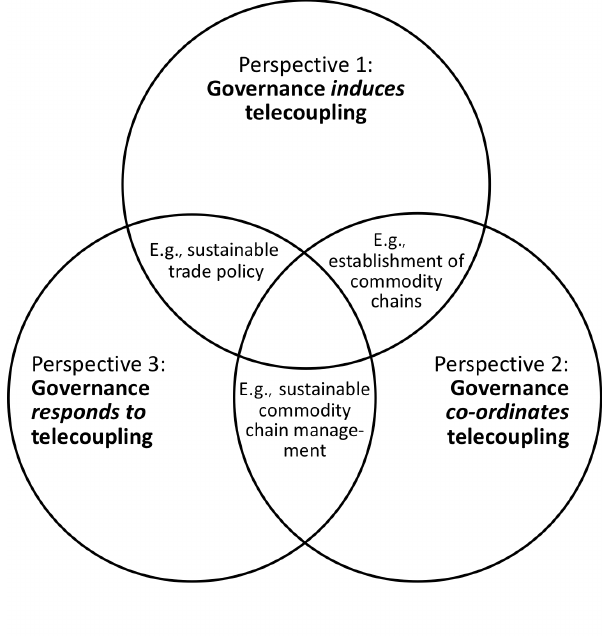
Fig. 1 . Three perspectives on governance regarding telecoupling including areas of overlap, with examples referring to global commodity